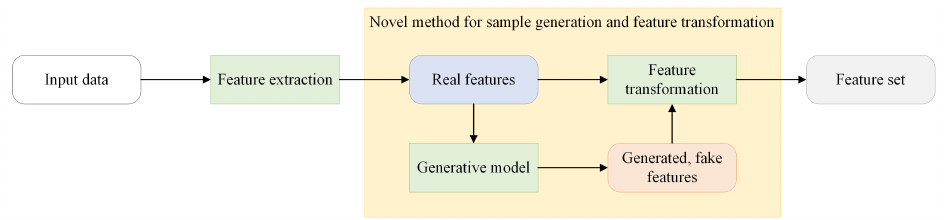
Figure 2. Schematic representation of the